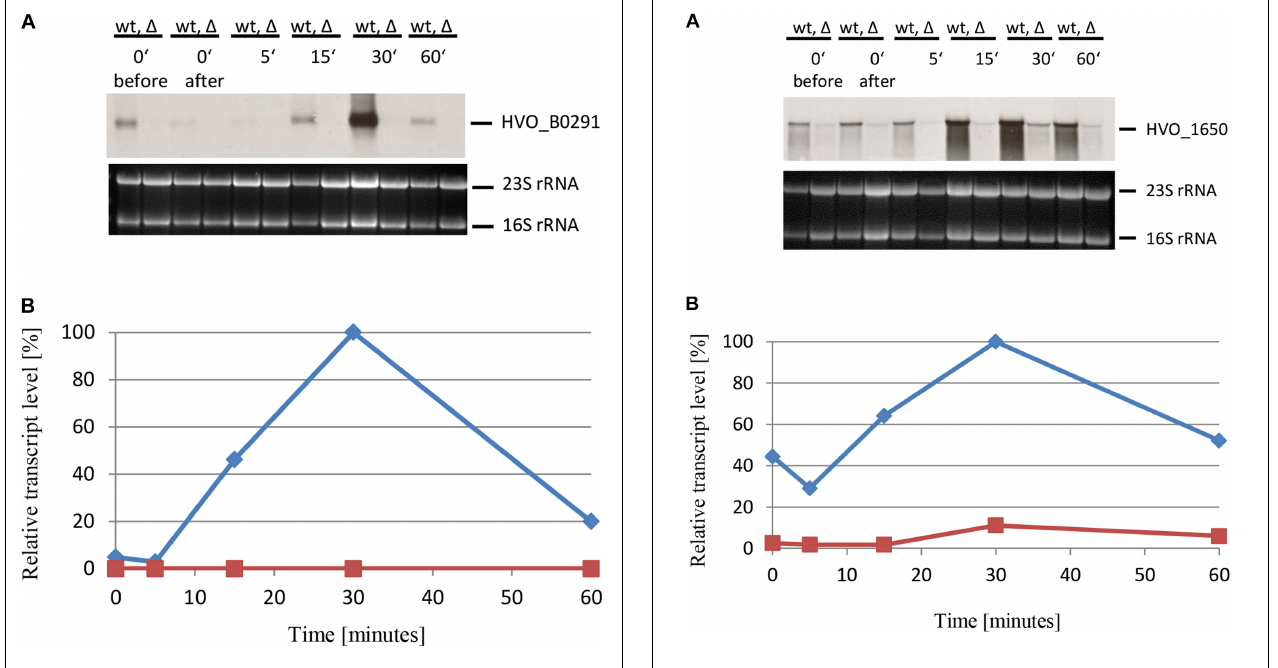
FIGURE 8 | Kinetic analysis of the HVO_B0291 mRNA level after the onset of phosphate starvation. (A) HVO_B0291 encodes a glycerophosphate diesterase. The wild-type (wt) H26 and the sRNA132 gene deletion mutant ( (cid:49) ) were grown to mid-exponential growth phase in the presence of phosphate (1 mM). The cells were harvested and resuspended in phosphate-free medium. At the time points indicated at the top aliquots were removed, RNA was isolated and used for Northern blot analysis with an HVO_B0291-specific probe. Ethidium bromide stained 23S and 16S rRNAs are shown at the bottom. (B) The signals of the Northern blots were quantified densitometrically, and the kinetic changes of relative transcript levels are shown.